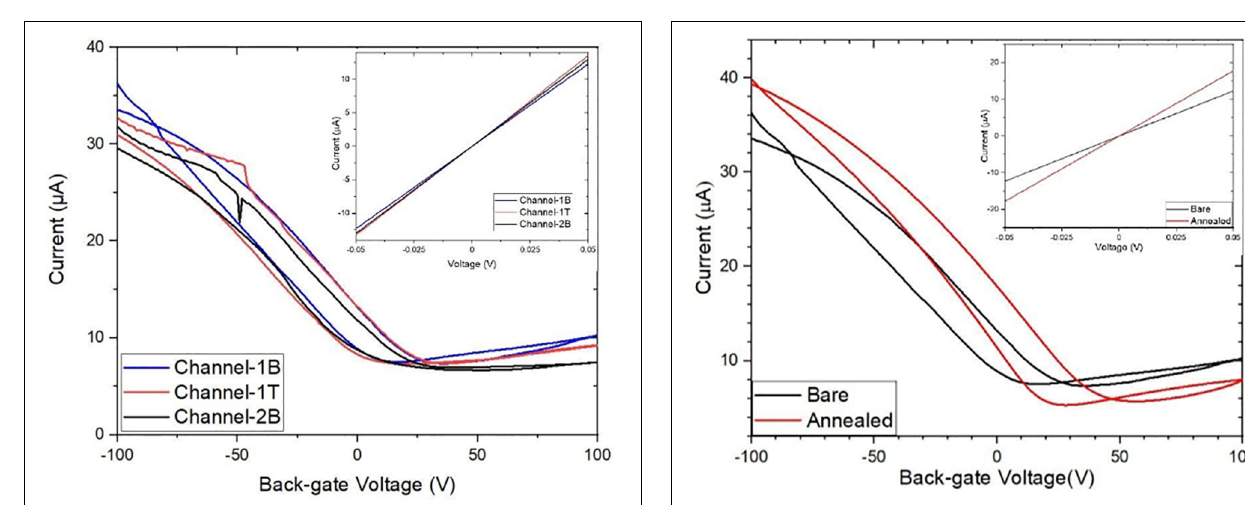
TABLE 1 | The forward and reverse Dirac point voltages (DPV) and the resistance of the three channels. The Dirac point voltages reveal that the GFET is p-doped. Back-gate sweep rate was ∼ 20 V/s.